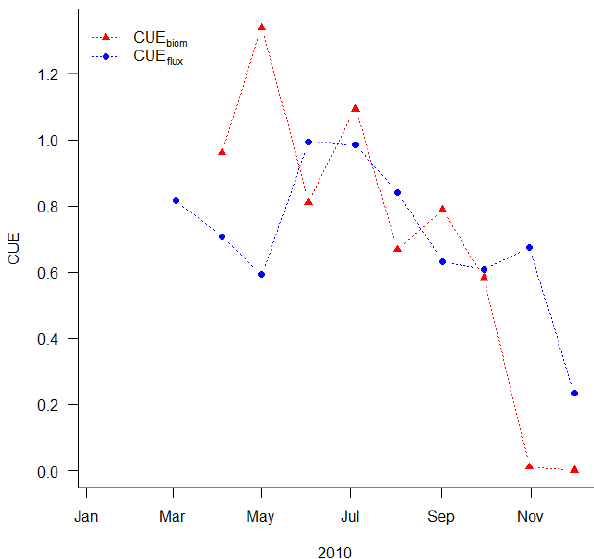
Fig. 8. Seasonal trend of the carbon use efficiency. Triangles rep- resent CUE values obtained by dividing NPP biom and GPP EC (CUE biom ) ; circles indicate CUE values obtained from the ratio be- tween NPP flux and GPP EC (CUE flux ) . Time period considered is the growing season 2010, from DOY 77 till DOY